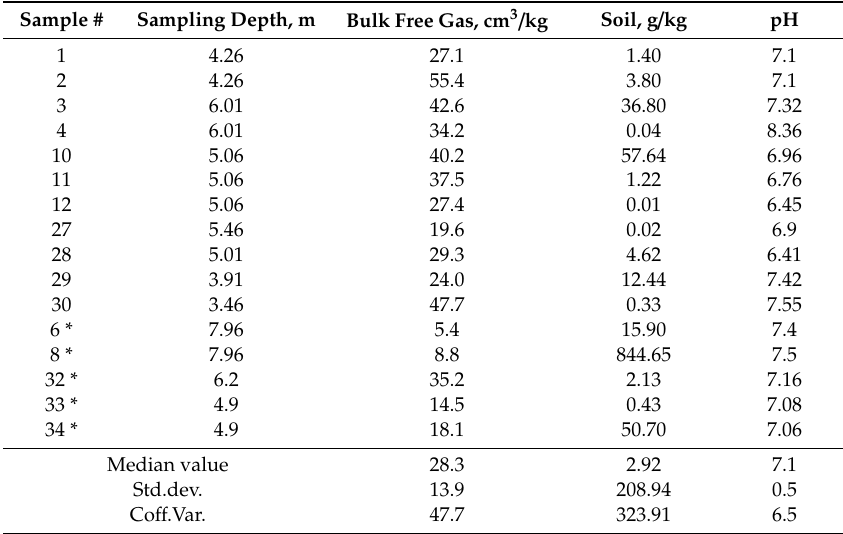
Table 2. Basic characteristics of the ground ice